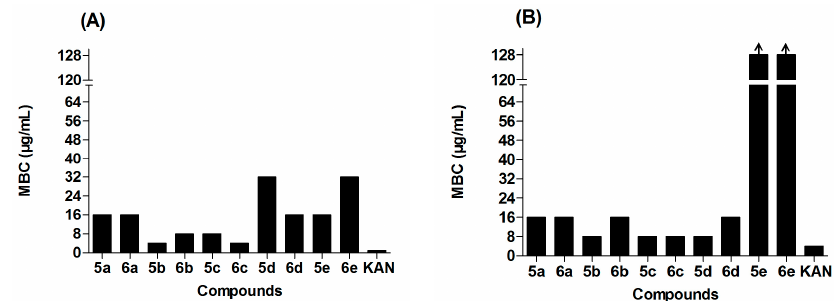
Figure 3. In vitro bactericidal activity of ocotillol-type derivatives against ( A ) B. subtilis 168 and ( B ) MRSA USA300. “ ↑ ”: MIC > 128 µ